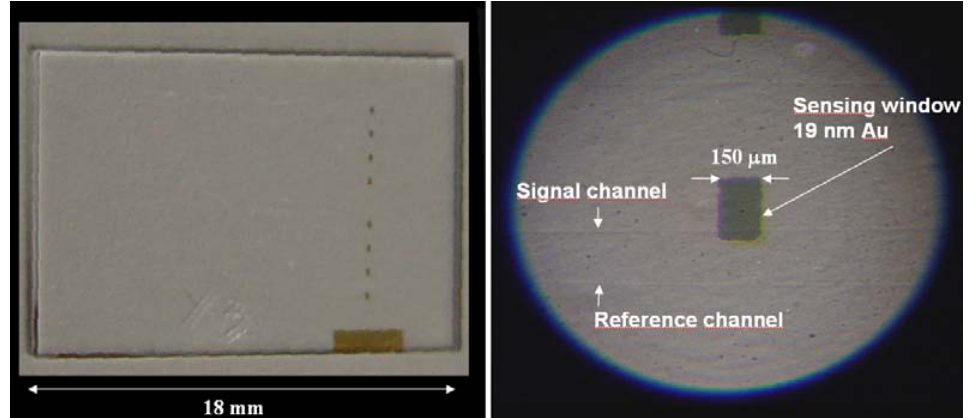
Figure 9. Photo and detail of the Y-junction